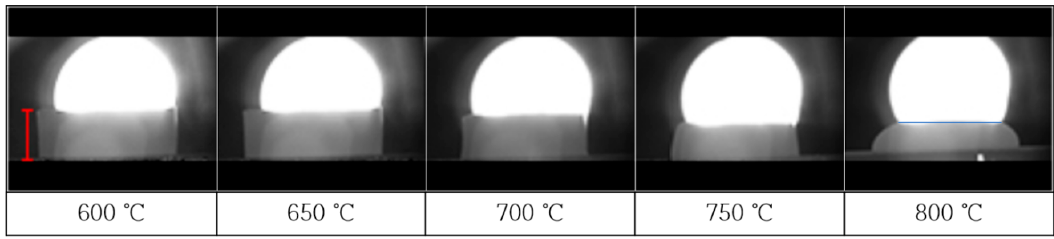
Figure 5. High-temperature microscope (HTM) images of SiO 2 –B 2 O 3 –RO glass frit (R = Ba, Zn) (Heating rate = 5 ℃ /min).